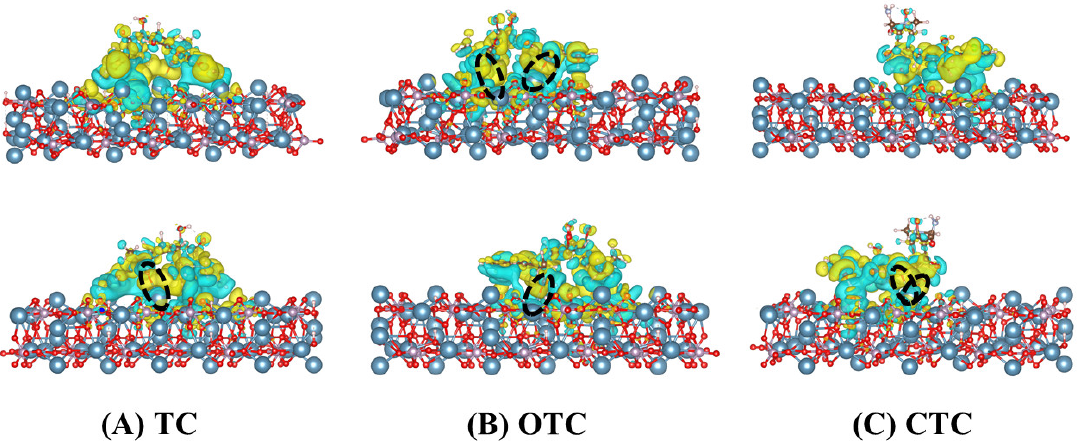
Figure 7. Charge density difference analyses of ( A ) TC, ( B ) OTC, and ( C ) CTC (two side views).